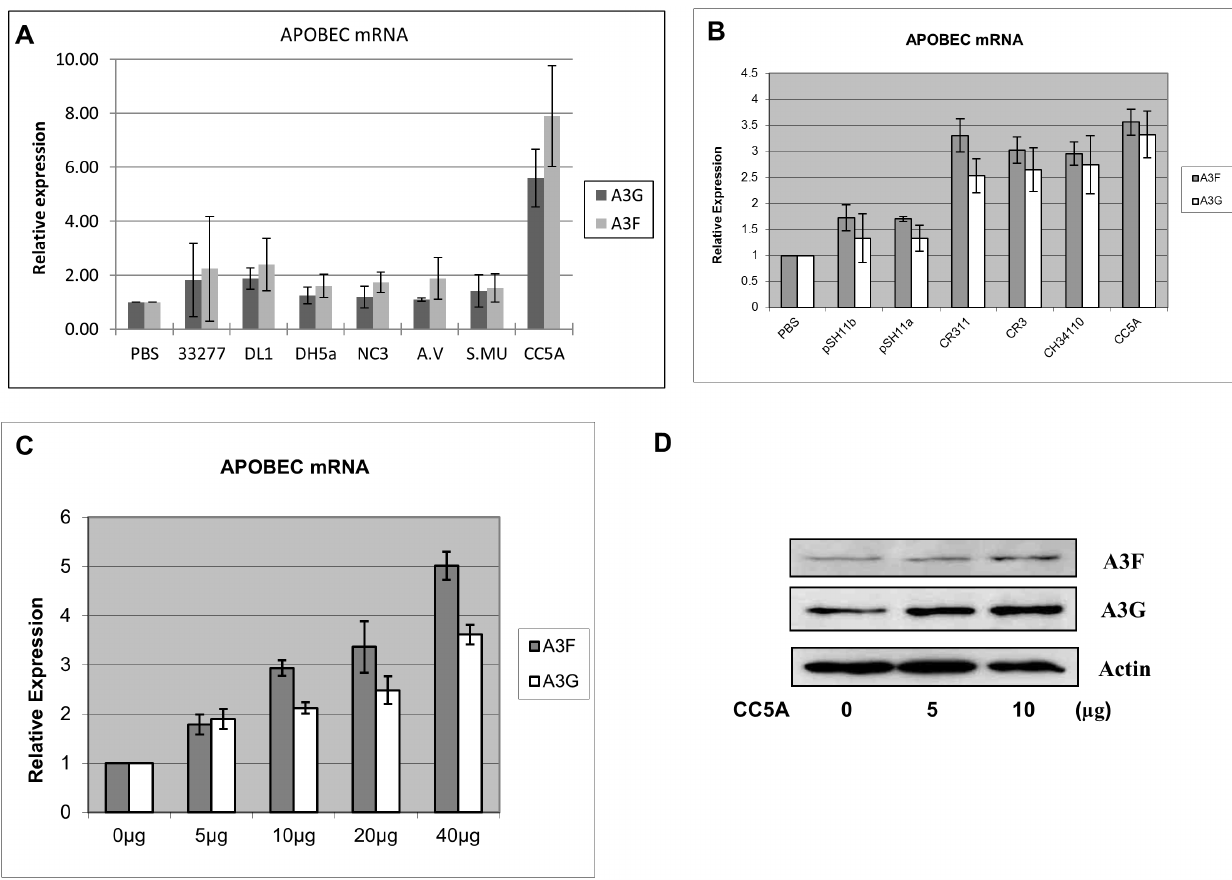
Figure 1. A molecule derived from oral Streptococcuscristatus induces APOBEC3F/G expression. (A) Cell extracts from NC3 ( Actinomyces naeslundii NC-3), DL1 ( Streptococcus gordonii DL1) and DH5a, CC5A ( S. cristatus CC5A), A.V ( Actinomyces viscosus ), 33277 ( Porphyromonas gingivalis 33277) and S.MU ( S. mutans KPSK2) were used to treat THP-1 cells. THP-1 cells treated by PBS were used as a control. After 16 h of exposure, total RNA was isolated and the expression of A3G and A3F quantified by qRT-PCR. (B) CC5A and different strains of S. cristatus (pSH11b, pSH11a, CR311, CR3, and CH34110) were used to treat THP-1. The induction of A3G and A3F was measured by qRT-PCR. (C) Different doses (0–40 m g) of CC5A/PBS were used to treat THP-1 cells for 16 h. A3G and A3F expression was measured by qRT-PCR. (D) A3G and A3F expression following a 48 h exposure